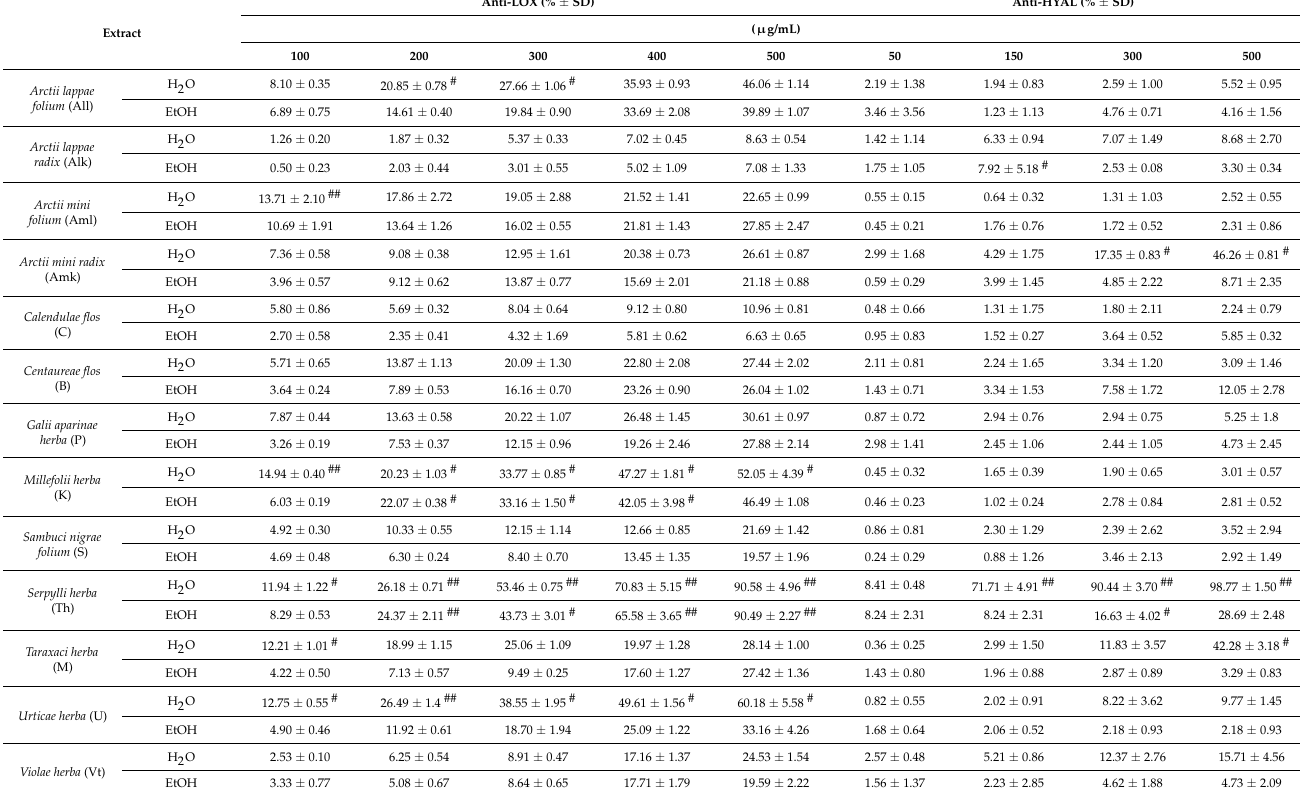
Table 1. The inhibitory effects on lipoxygenase (LOX) and hyaluronidase (HYAL) activity of the tested extracts. IC 50 (subScheme 50 of the maximum inhibition) for all the tested extracts was higher than 100 µ g/mL. ## —the most active extract/extracts ( p < 0.001), # —extracts with higher activity than the others but weaker than the most active ones ( p < 0.01). Anti-LOX(% ± SD) Anti-HYAL(% ± Extract